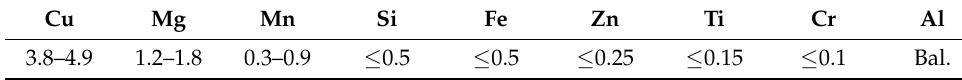
Table 2. Chemical composition (in wt.%) of AA2024-T351